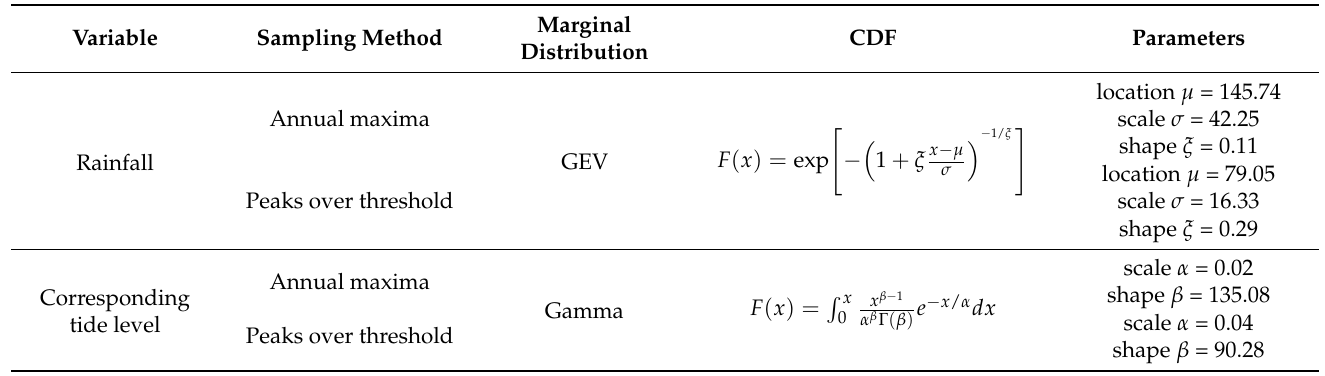
Table 3. CDFs of marginal distributions and their associated parameters.